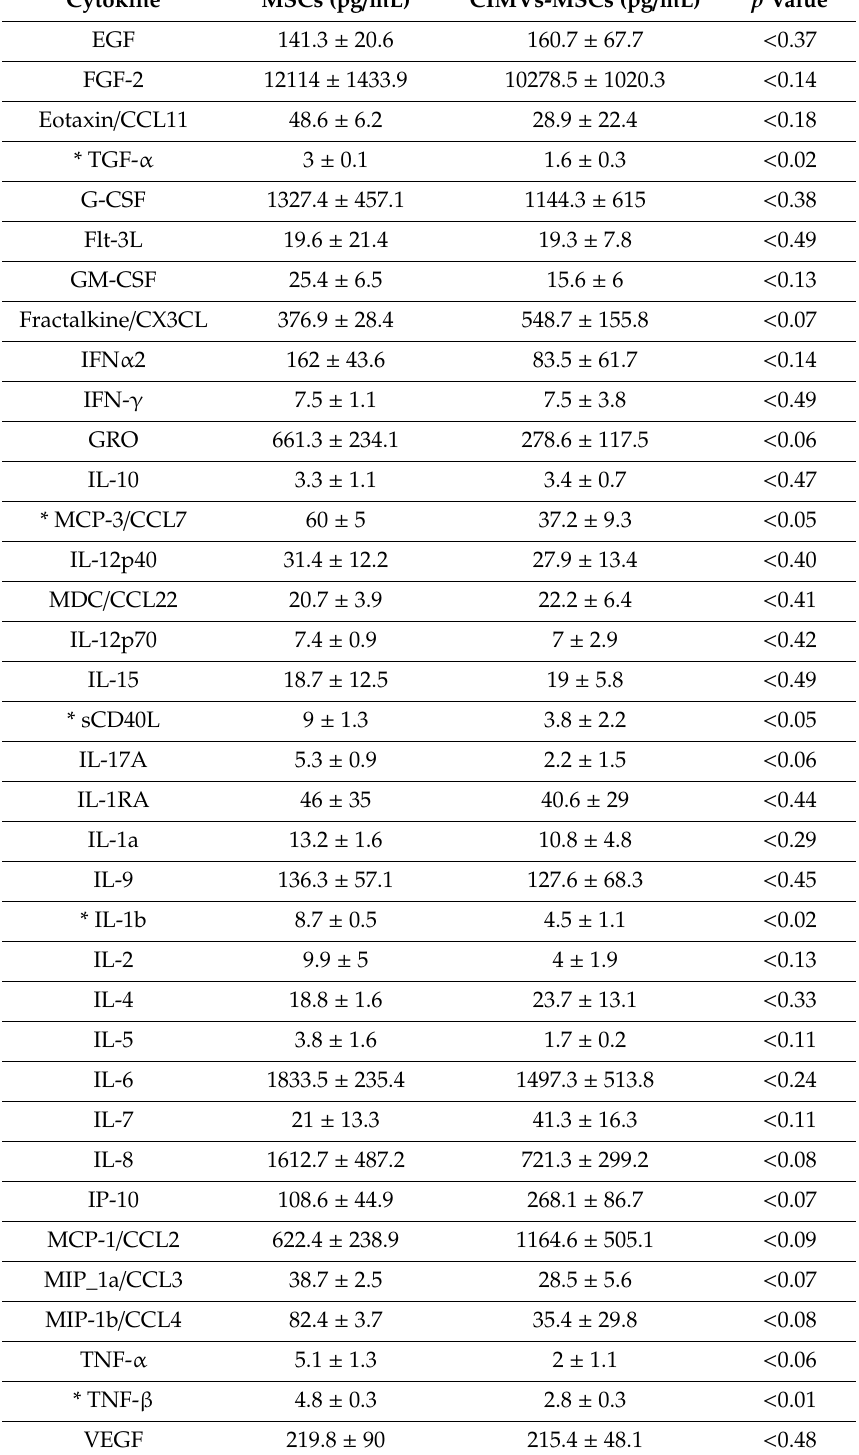
Table 1. Cytokine analysis of MSCs and CIMVs-MSCs